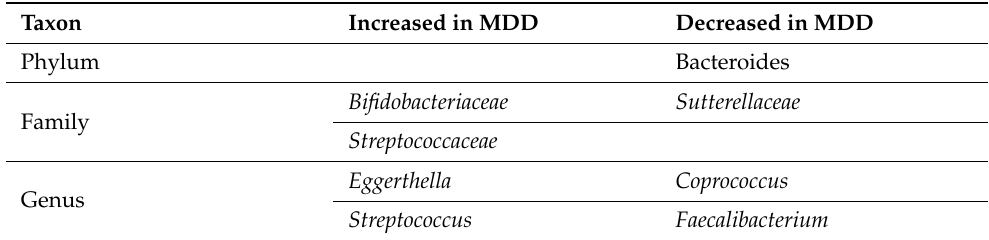
Table 3. Summary of taxa abundance changes in patients with major depressive disorder relative to healthy controls a